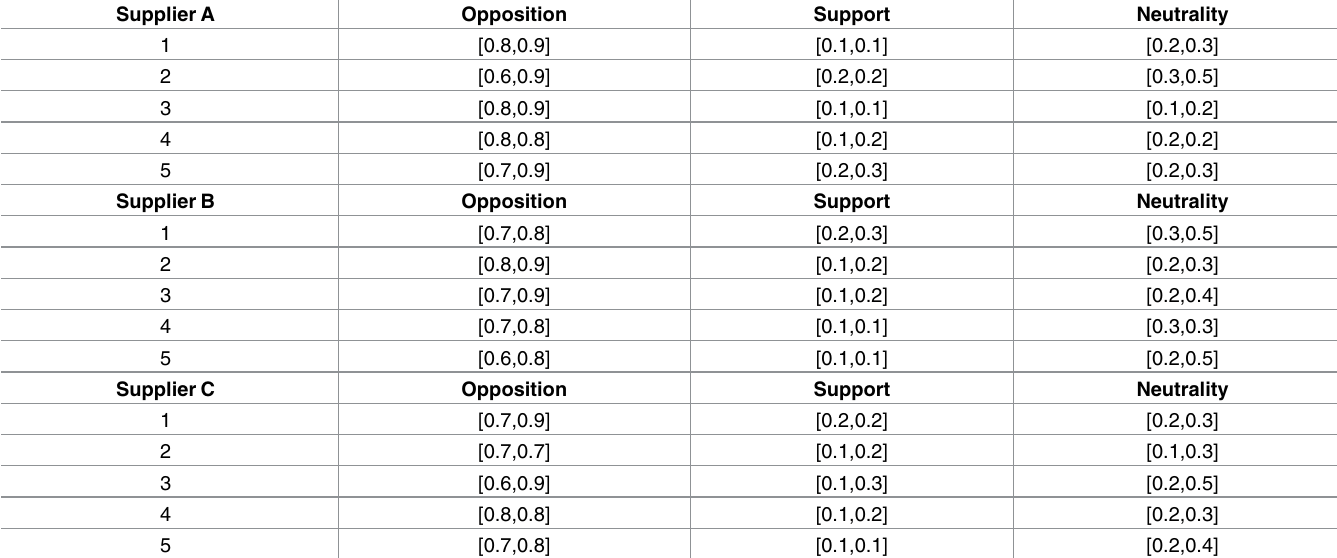
Table 2. The choice decision matrix of supplier (A, B,